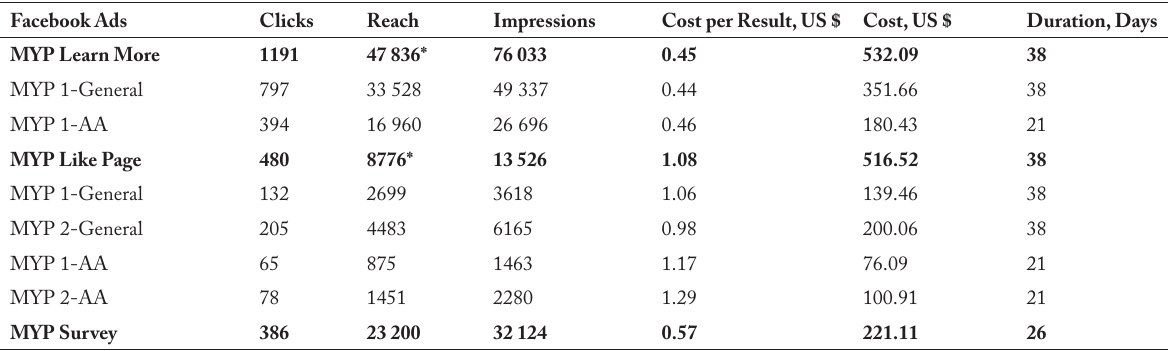
Table 1. Facebook advertisement metrics for the Measure Your Pressure (MYP) online health campaign.